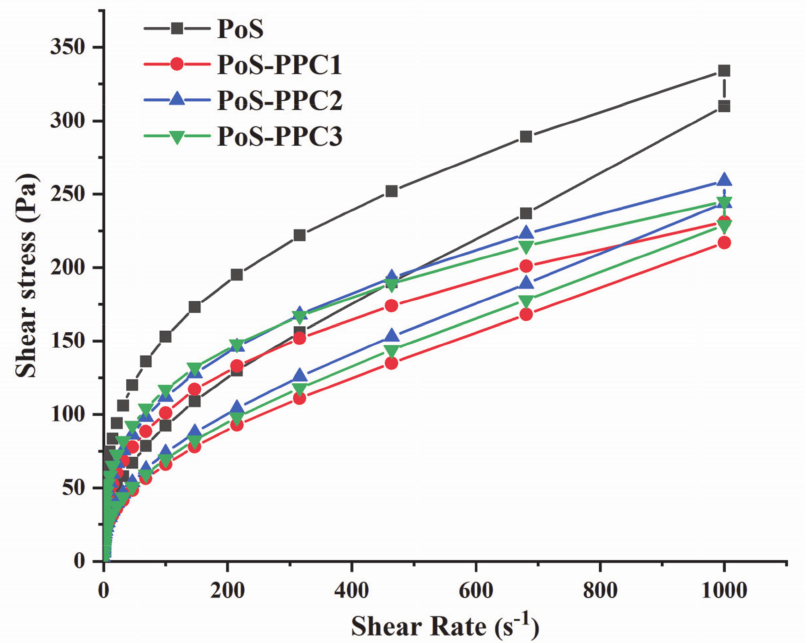
Figure 2. Steady flow curve of PoS and PoS-PPC pastes. PoS: potato starch; PPC: polymeric